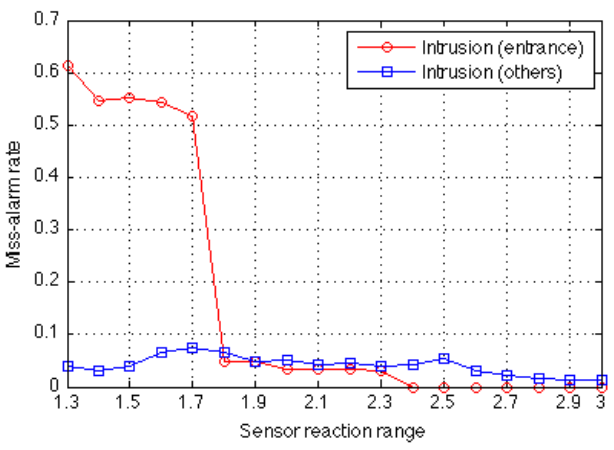
Figure 11. Missed-alarm rate decreases if the profile describing abnormal activity (intrusion from the entrance and from other places) is